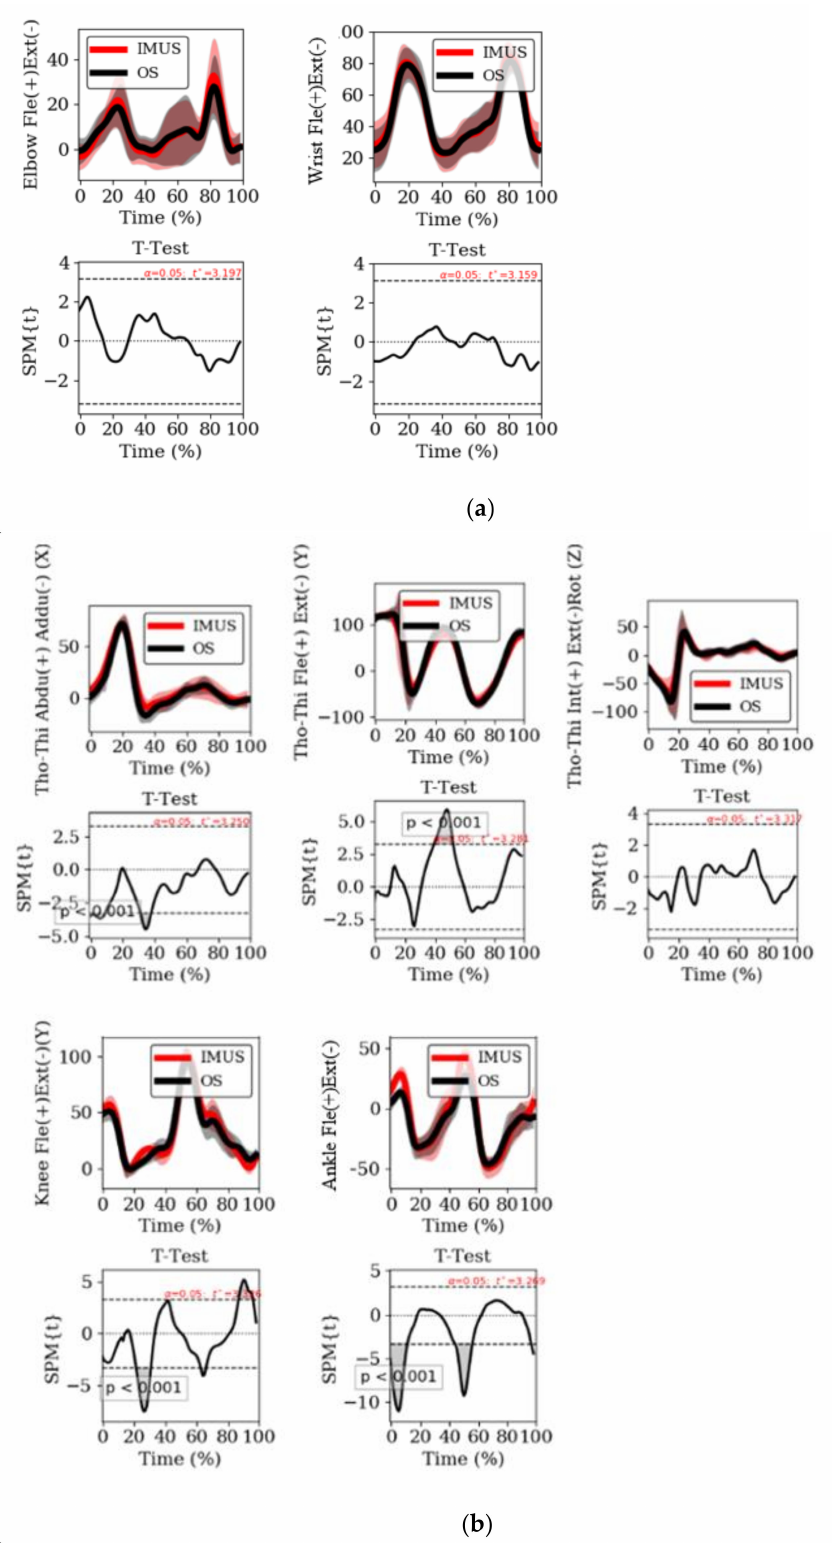
Figure 3. ( a ) Mean joint kinematic angles time series with SD clouds for upper body. ( b ) Mean joint kinematic angles time series with SD clouds for thorax and lower body. SPM-1D {t} is the mean difference curve normalized by the sample size normalized variance. The dotted horizontal lines represent the Random Field Theory threshold for significance. p -values indicate the likelihood that a random process of the same temporal smoothness would be produce a supra-threshold cluster of the observed size. Note: Tho-Thi = Thorax–thigh, Abdu(+)/Addu( − ) = Abduction(+)/Adduction( − ), Fle(+)/Ext( − ) = Flexion(+)/Extension( − ), Int(+)/Ext( − )Rot. = Internal(+)/External( − )